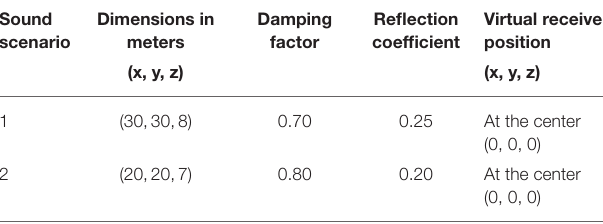
validation and testing sets. During this study, 60% of the iKala and MUSDB data sets were used as the training data set, 20%